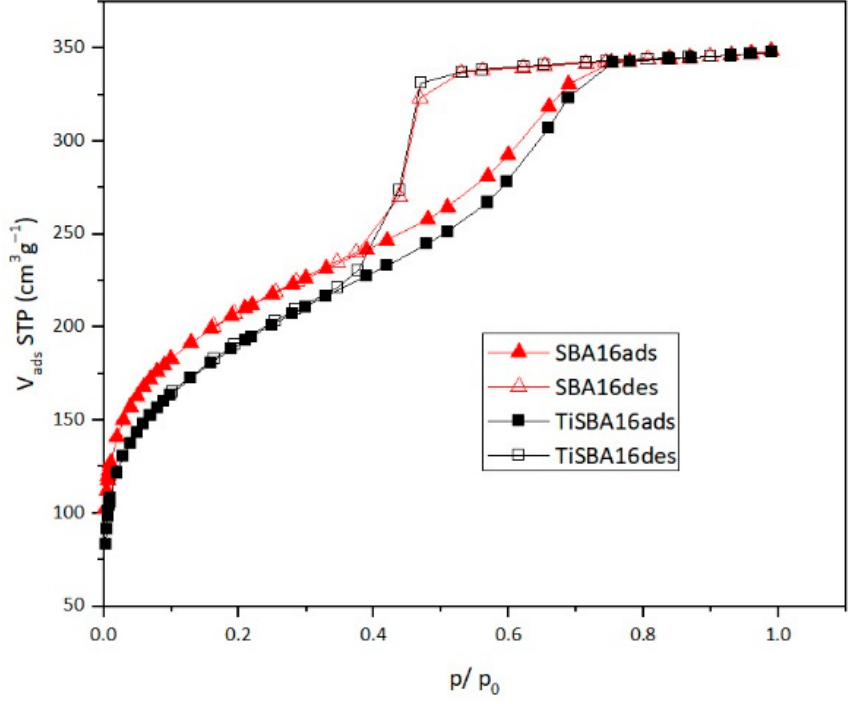
Figure 3. Nitrogen adsorption–desorption isotherms at 77 K of SBA-16 and Ti-SBA-16.